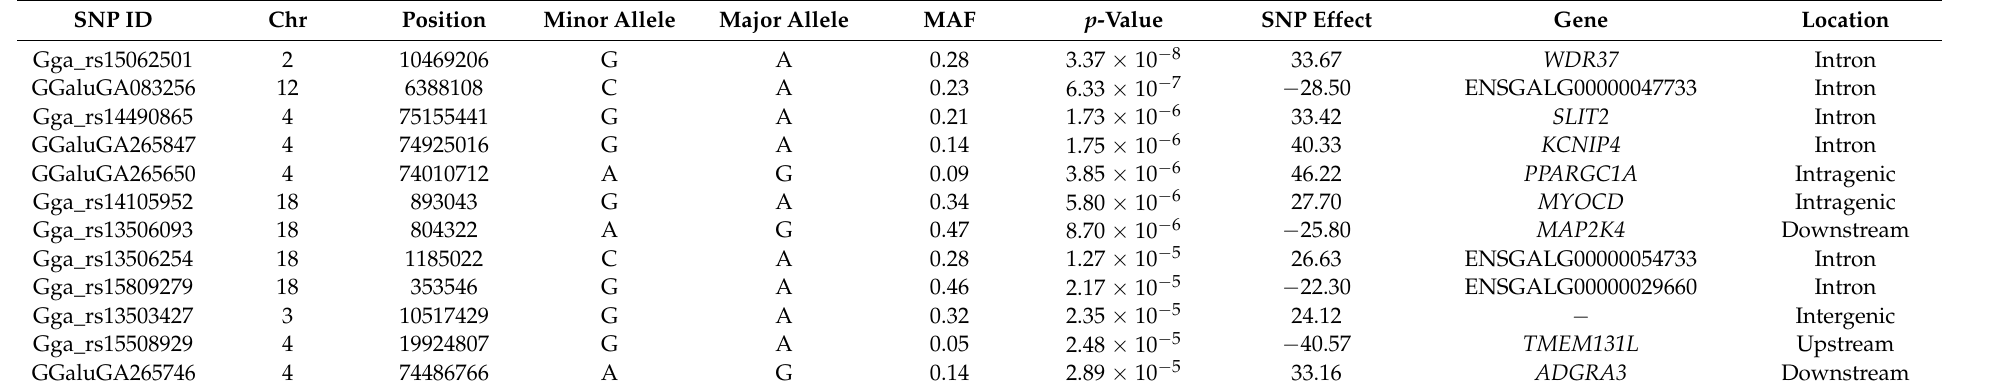
Table 3. Top single nucleotide polymorphisms (SNPs) associated with body weight trait identified using a linear mixed model